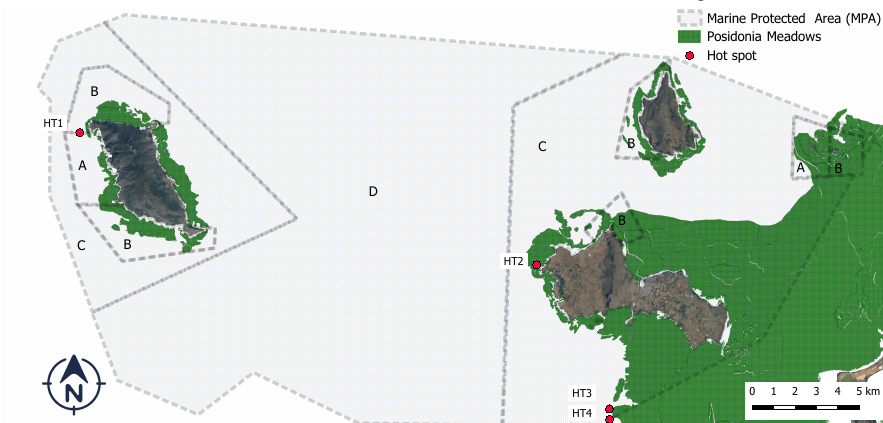
Figure 1. Map of Aegadian islands showing the distribution of Posidonia oceanica meadow (from data produced by Italian Ministry of the Environment). The area enclosed by dotted lines shows the Marine Protected Area. The upper case letters A, B, C and D show the different reserve